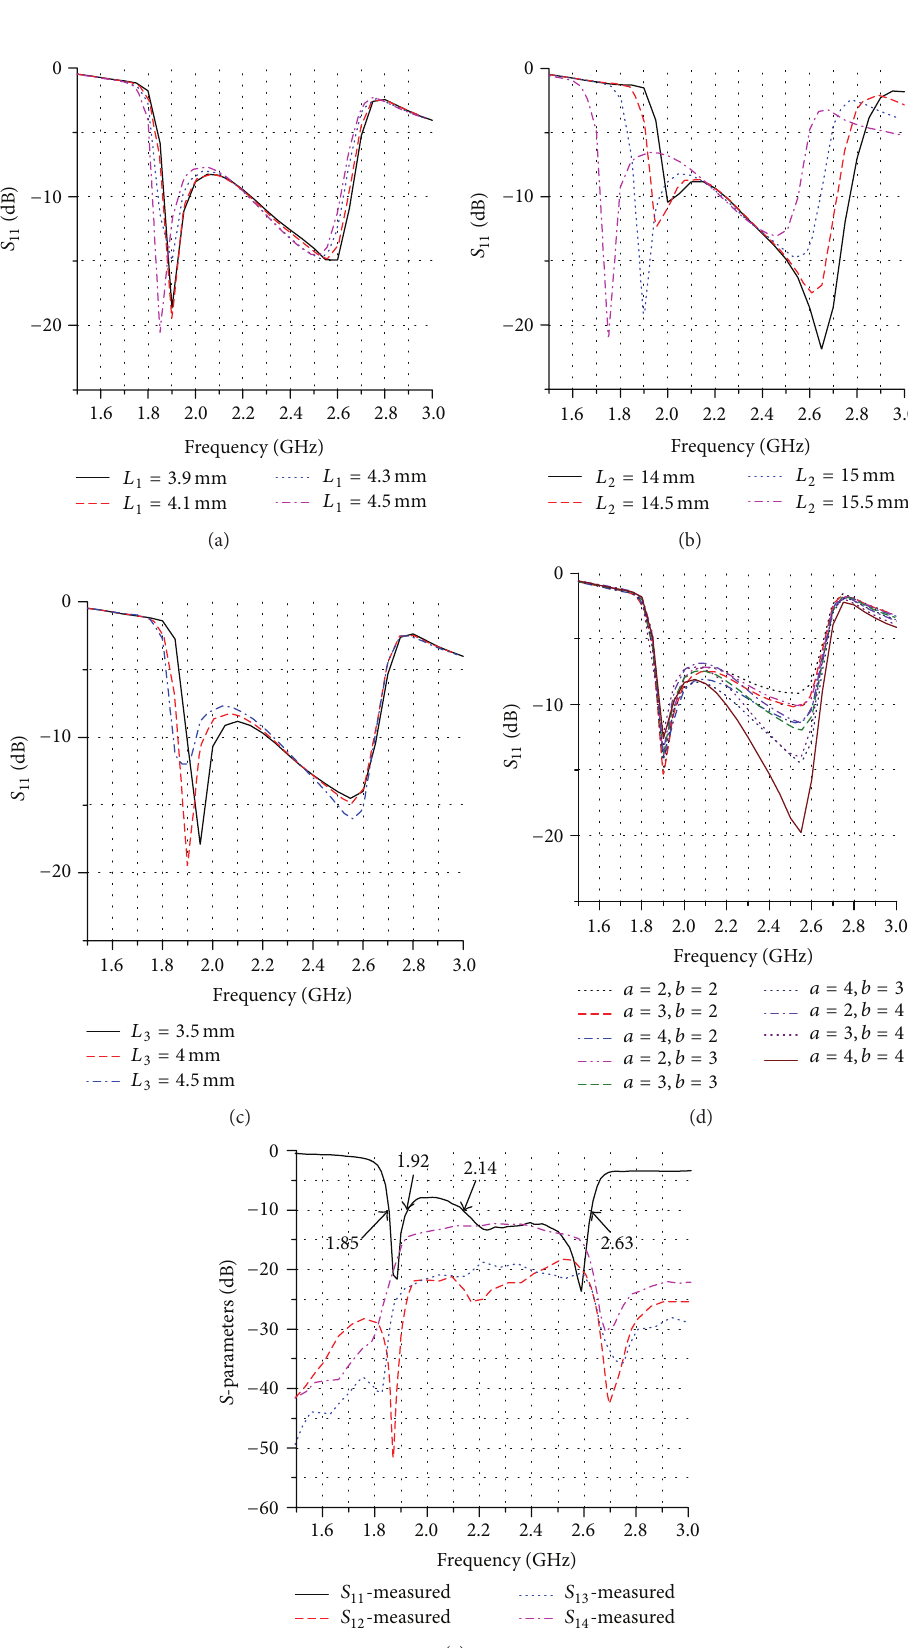
Figure 5: (a)–(d) 𝑆 -parameters with different 𝐿 1 , 𝐿 2 , 𝐿 3 , 𝑎 , and 𝑏 ; (e) measured 𝑆